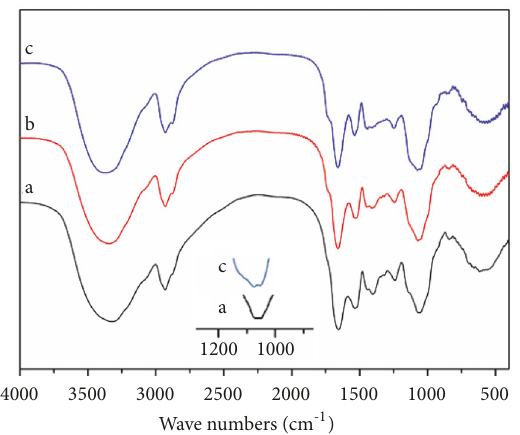
Figure 3: FTIR spectra of EGDE/SF adhesives: (a) A; (b) D; (c) F.